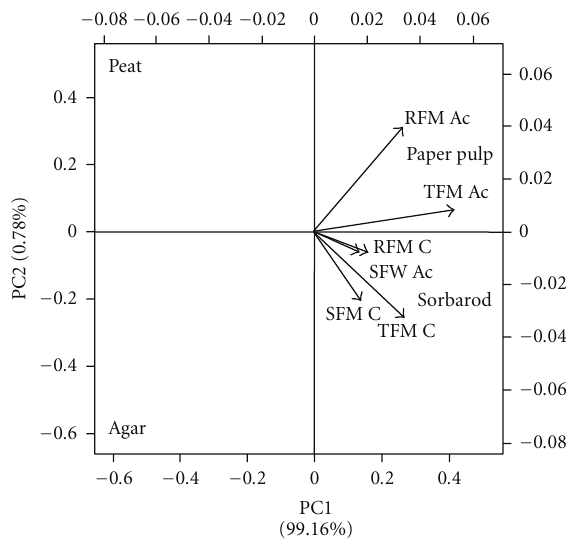
Figure 5: Biplot of nonlinear principal component analysis of in vitro cultured and acclimatized nemesia in the four substrates. RFM Ac: root fresh mass of acclimatized nemesia; RFM C: root fresh mass of in vitro cultured nemesia; SFM Ac: shoot fresh mass of acclimati- zed nemesia; SFM C: shoot fresh mass of in vitro culture nemesia; TFM Ac: total fresh mass of acclimatized nemesia; TFM C: total fresh mass of in vitro cultured nemesia. N.B.: dry masses are not visible due to high clustering near the